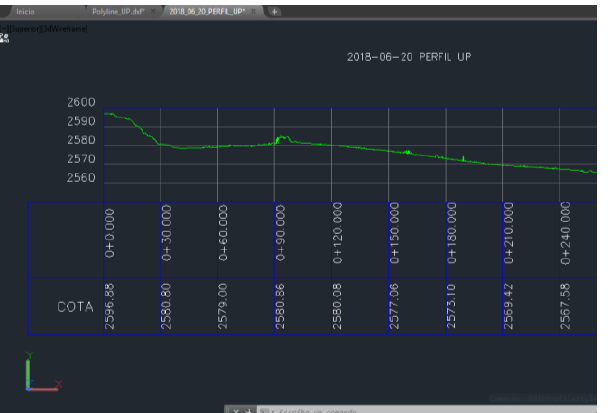
Figure 13. Up transversal profile creation, Jun 20, 18.